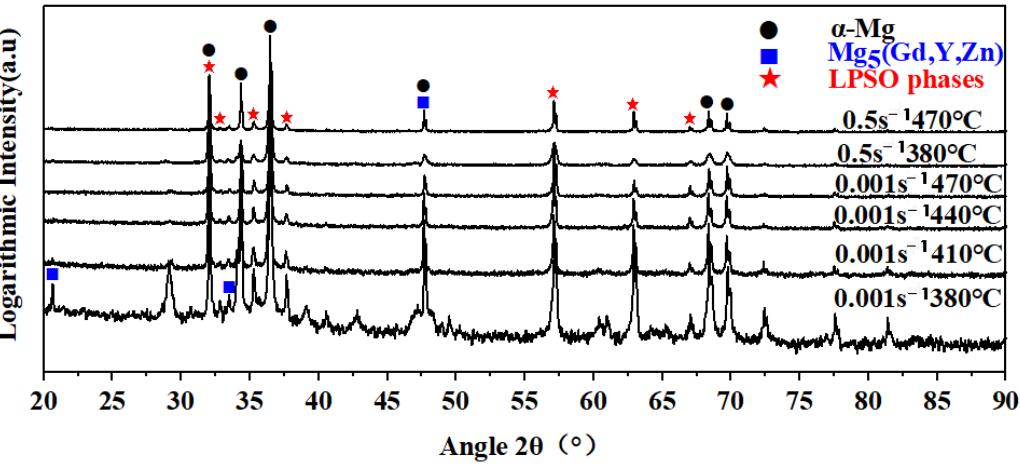
Figure 10. XRD patterns of deformed samples under different deformation conditions.